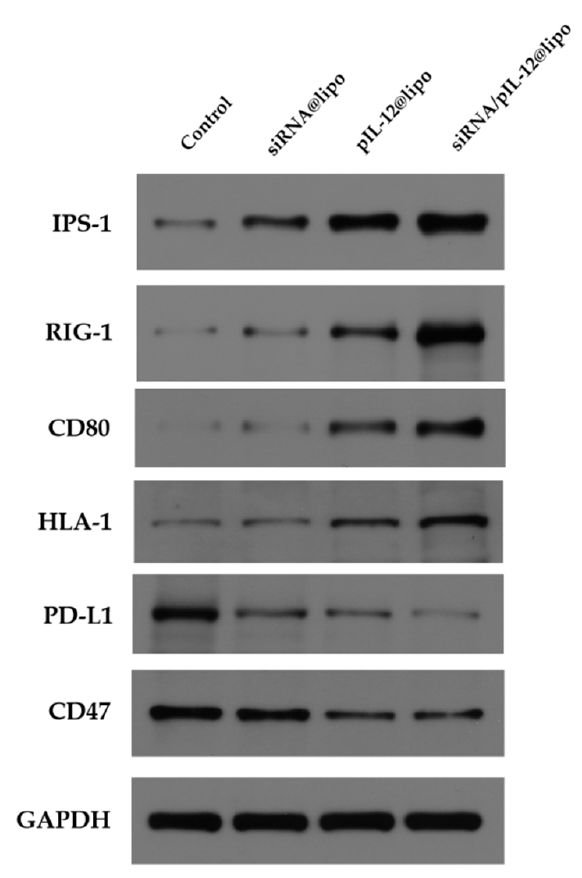
Figure 5. Western blot analysis of IPS-1, RIG-1, CD80, HLA-1, PD-L1, and CD47 in HepG2.215 cells treated with siRNA- and/or pIL-12-loaded complexes for 48 h at the siRNA concentration of 60 pmol/mL and/or the pIL-12 concentration of 1 µ g/mL. HepG2.215 cells without treatment were used as a control.